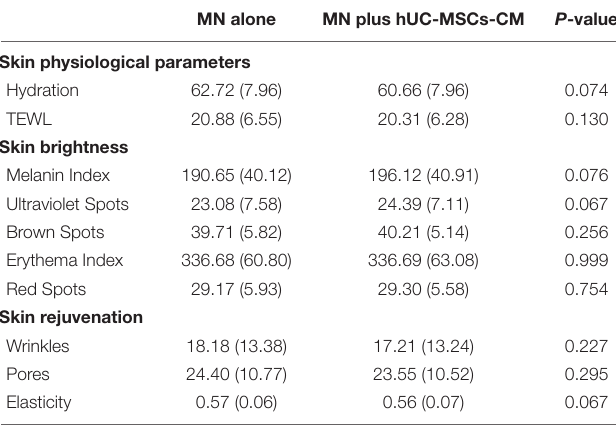
TABLE 4 | Objective assessment at baseline.